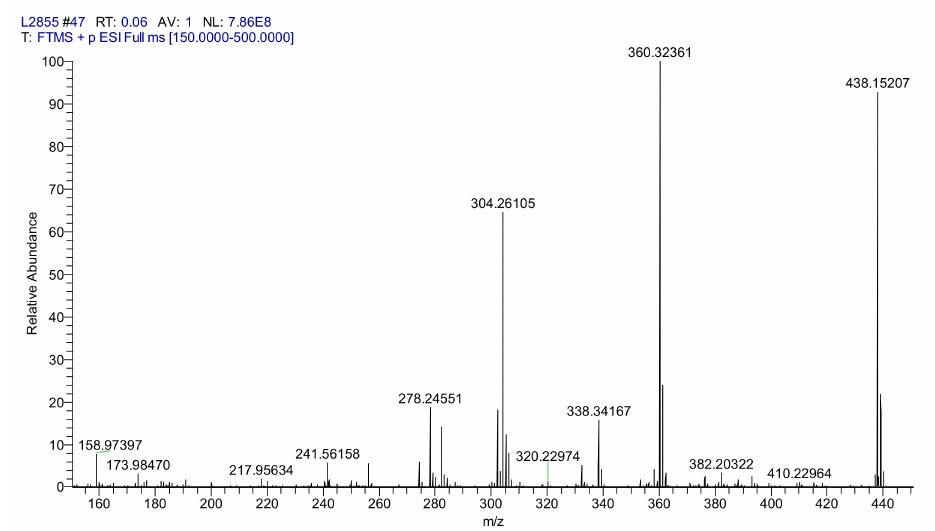
Figure 9. HRMS spectrum of